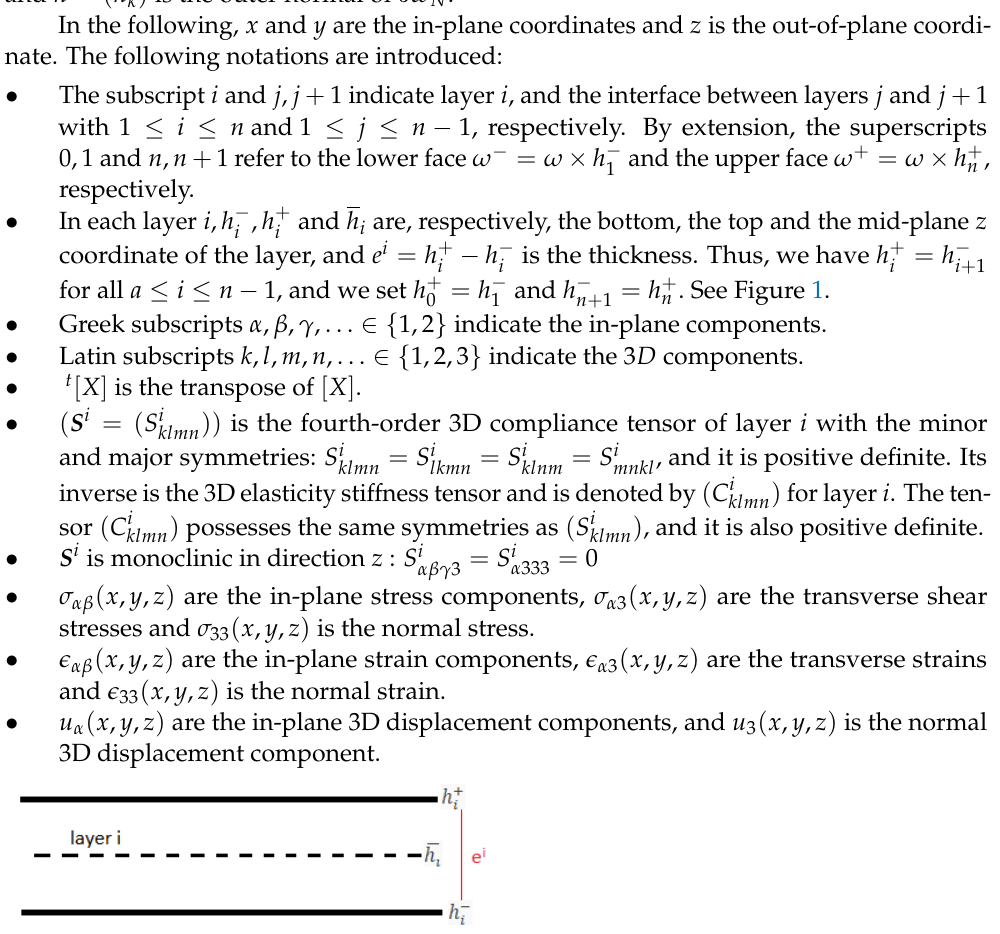
Figure 1. Notation in a